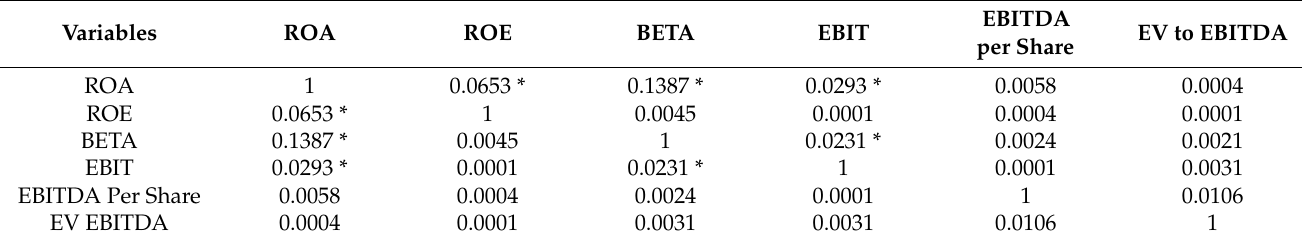
Table 4. Spearman correlations coefficient between independent variables.